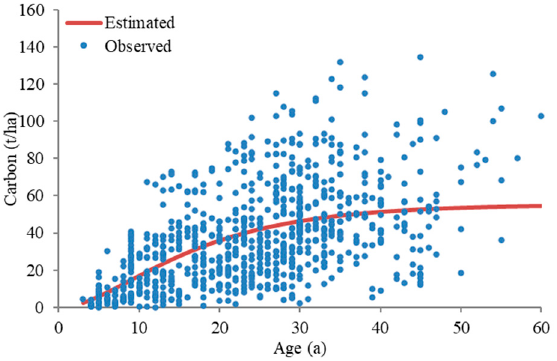
Figure 2. The fitting effect of carbon growth in the Larix plantation.